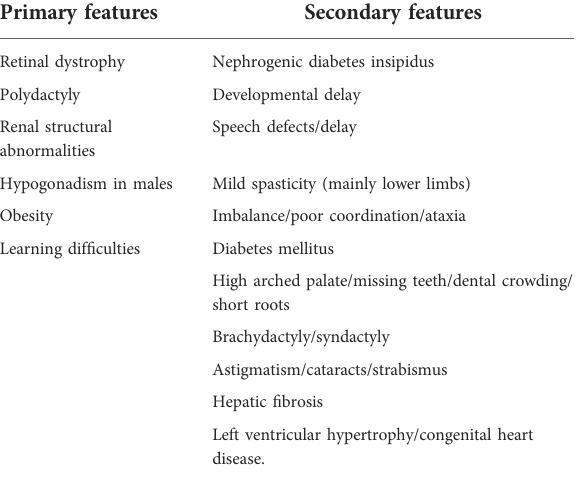
TABLE 1 Diagnostic criteria for Bardet – Biedl syndrome